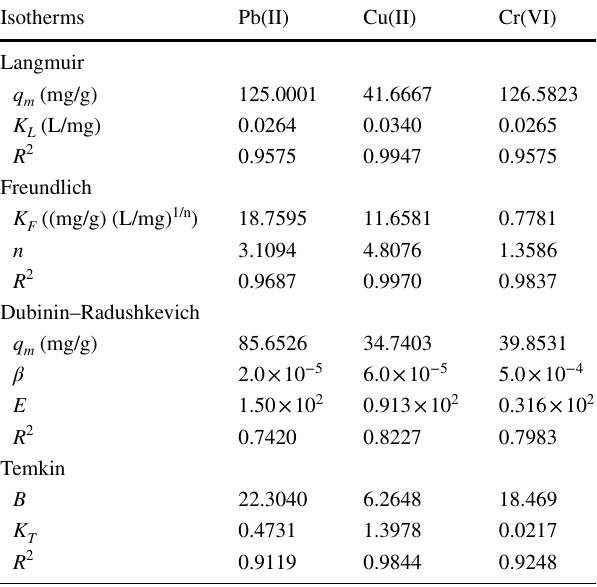
Table 4 Isotherm constants obtained for heavy metal adsorption